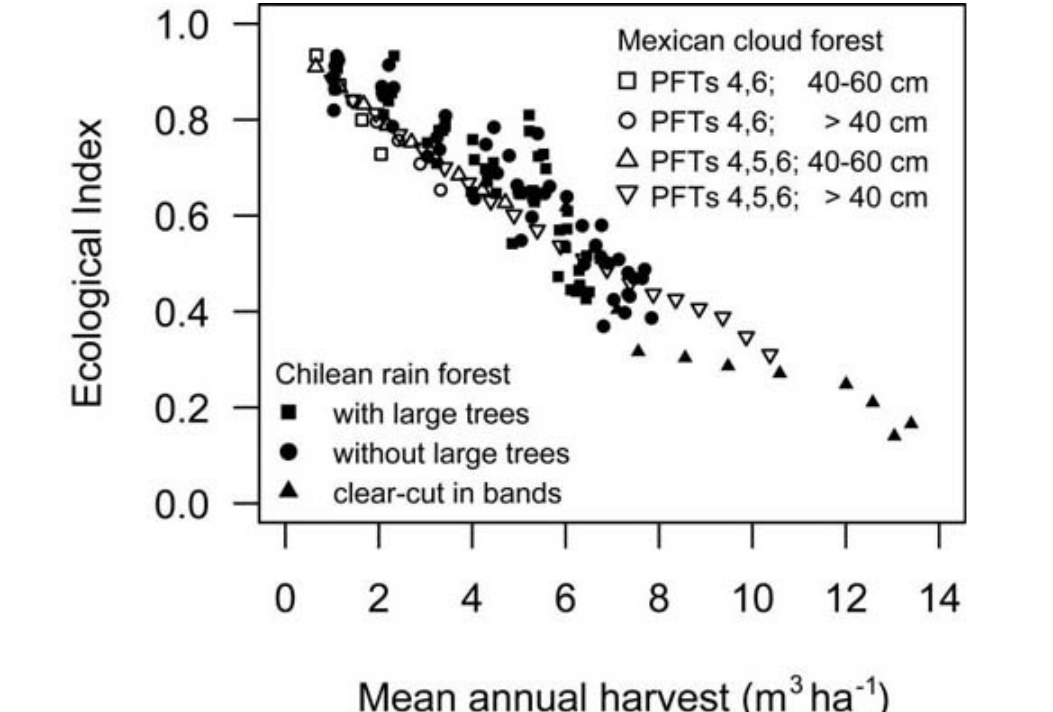
Fig. 7. Ecological Index (EI) vs. mean annual harvest for four selective-logging strategies of tropical montane cloud forest in central Veracruz, Mexico, which target only specific plant functional types (PFTs) and diameter ranges and three logging strategies (selective logging with and without large-tree retention, clearcutting in narrow bands) of Valdivian temperate rainforest in northern Chiloé Island, Chile. EI provides a combined measure of structural change, compositional change, stand leaf area index, and the number of old trees (>1 m dbh) (for full details, see Rüger et al. 2007b). Undisturbed old- growth forest has an EI value close to